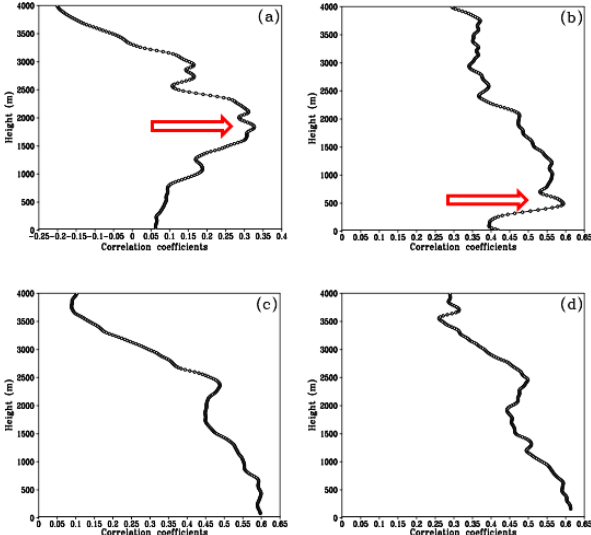
Figure 10. Correlation coefficient profiles between the surface PM 2 . 5 concentration (12h intervals) and atmospheric temperature from L-band soundings for representing low-frequency light rain regions at stations of (a) Changsha and (b) Hongjia in EC, and for representing high-frequency light rain regions in relatively clean ar- eas at stations in (c) Nyingchi and (d) Dingri over the TP with cor- relation coefficients of 0.21, 0.25 and 0.32, passing the confidence level of 90, 95 and